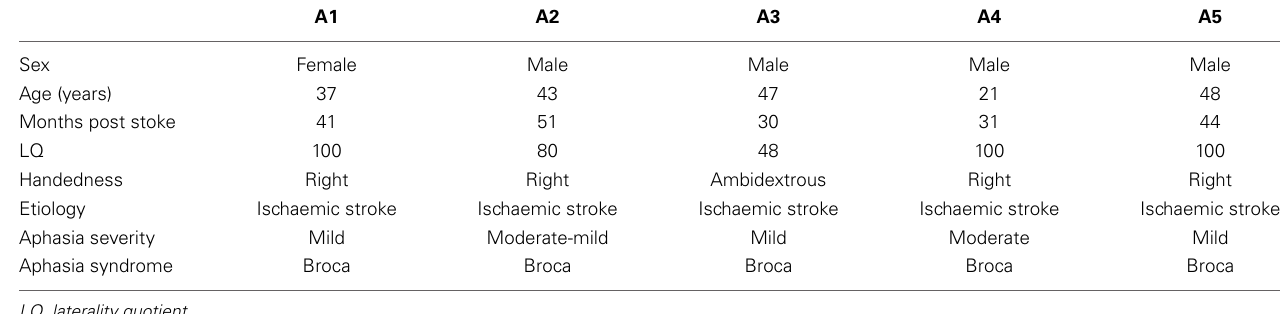
Table 1 | Aphasic speakers’ (A1–A5) demographic and clinical data.